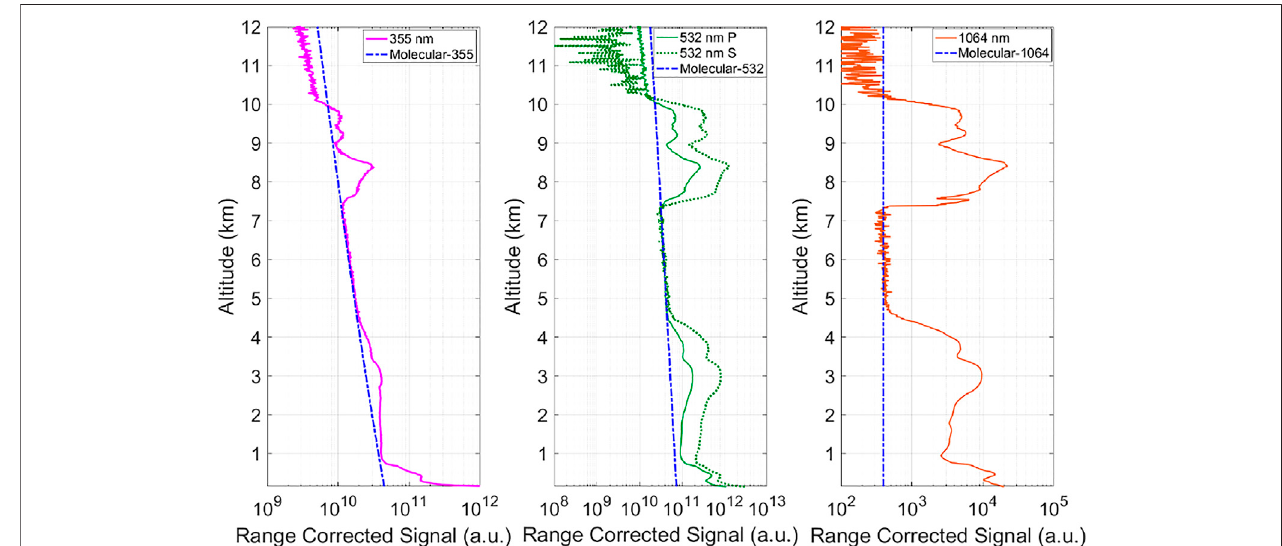
FIGURE 7 | Comparison of lidar range corrected signals and molecular Rayleigh signals of 355 nm, 532, and 1064 nm.